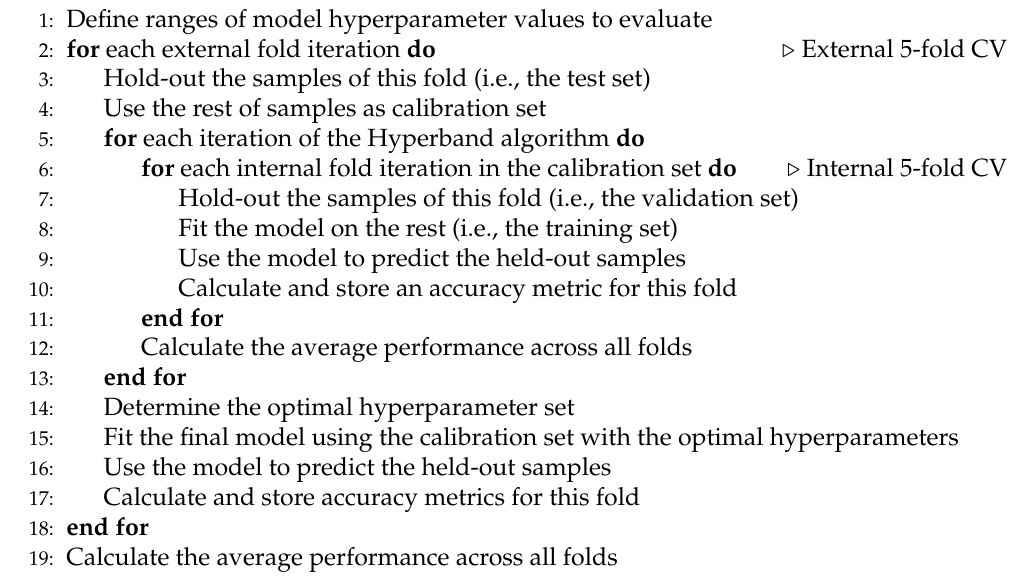
Algorithm 2 Model training and hyperparameter optimization for the CNN